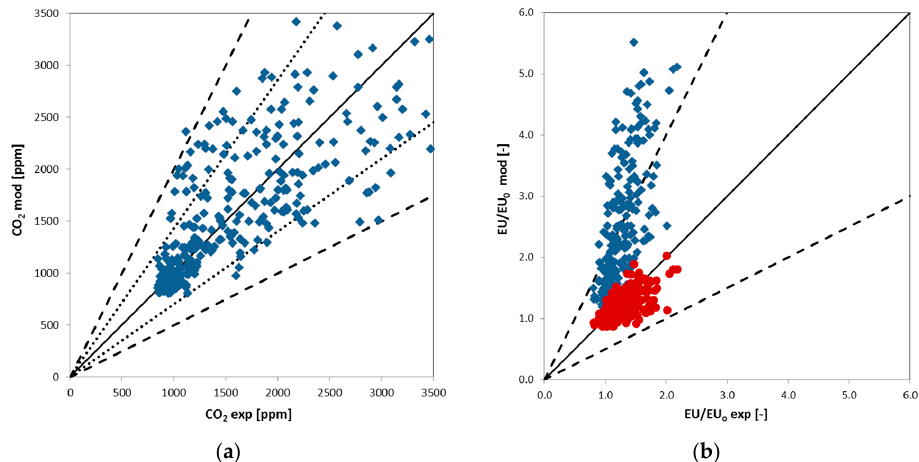
Figure 8. Parity plots of model predictions versus experimental observations for CO 2 ( a ) and EU/EU 0 ( b ) found during the indoor monitoring campaign (blue diamonds symbols refer to predictions obtained with average CO 2 and odour (OEF n ) emission rates estimated for the room occupants, while red circle symbols represent the predictions obtained considering only a 20% contribution of the room occupants to the odour emission trends).